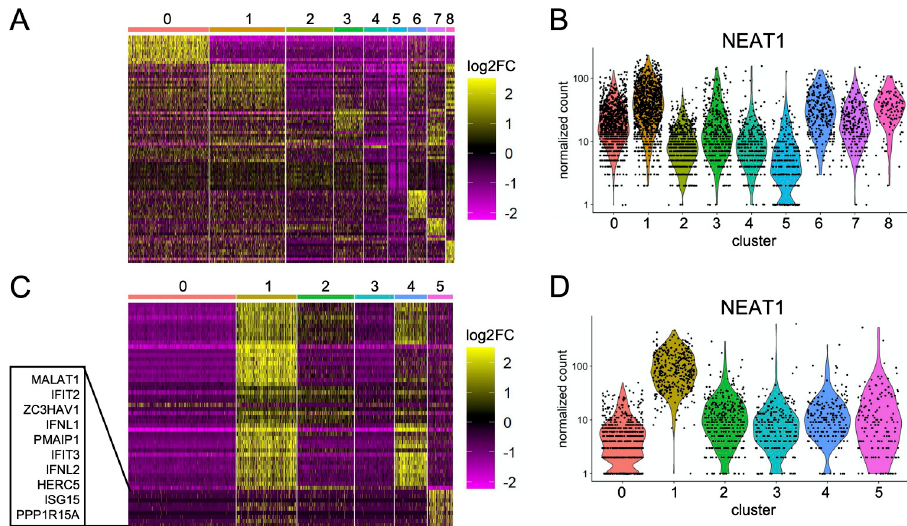
Fig 4. Substantial virus strain-specific variation in the expression patterns of critical determinants of IAV infection outcome. (A) Heat map showing differential expression of the top 10 characteristic host genes for each cluster of Cal07-infected cells (from Fig 3A). Individual cells are each represented by a column, grouped by cluster, with individual rows representing relative expression of the top 10 specific host transcripts most significantly (lowest p values) associated with each cluster. (B) Comparison of normalized per cell counts of NEAT1 between clusters of Cal07-infected cells shown in (A). (C) Same heat map as (A) for each cluster from Perth09-infected cells (From Fig 3D), with the top 10 genes defining cluster 5 highlighted. (D) Comparison of normalized per cell counts of NEAT1 between clusters of Perth09-infected cells shown in